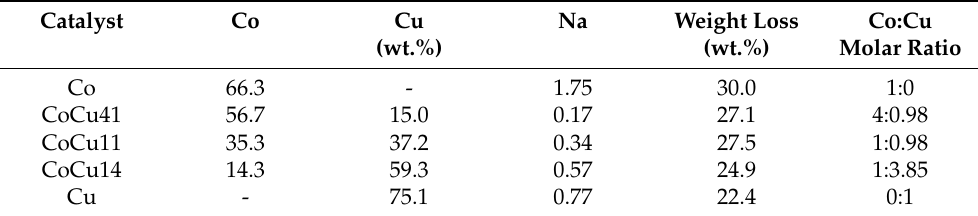
Table 1. Content of Co, Cu, and Na in the prepared Co-Cu oxide catalysts and weight loss determined after 4 h calcination of the dried precursors at 500 ◦ C in